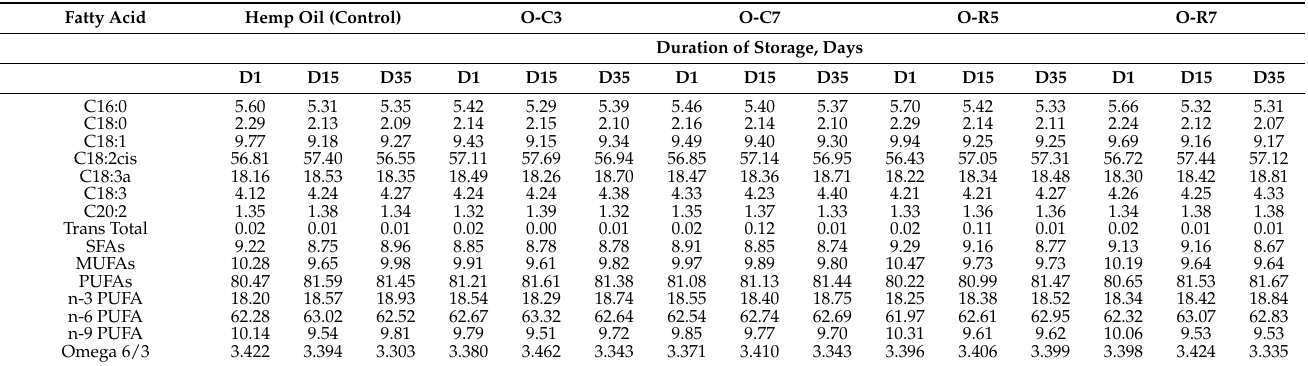
Table 1. Fatty acid profile of the hemp oil and oleogels during